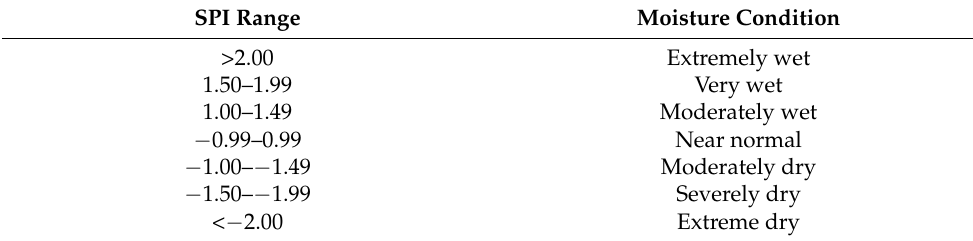
Table 2. Classification of drought conditions according to the range of each drought index.